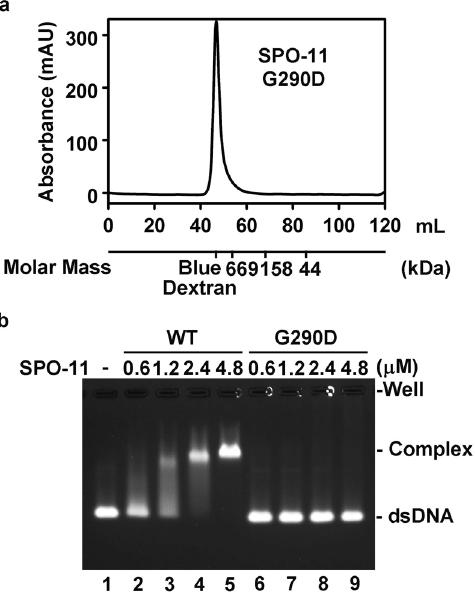
Figure 7. Characterization of the C. elegans SPO-11 G290D mutant. ( a ) Gel filtration analysis indicated that the SPO-11 G290D mutant protein is prone to forming a soluble aggregate. ( b ) The indicated concentration of wild- type SPO-11 (WT) or G290D mutant protein was tested for DNA binding using the 100 bp dsDNA as